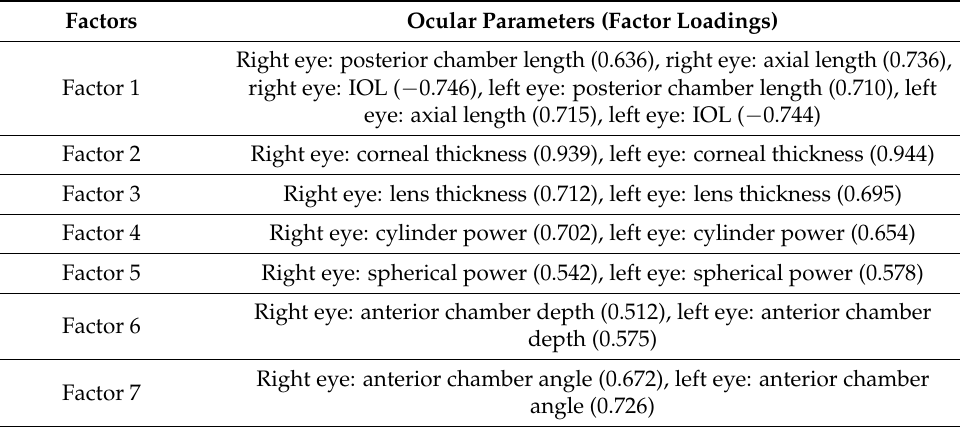
Table 2. List of ocular parameters and their factor loadings for seven groups (factors) identified by the principal component analysis.